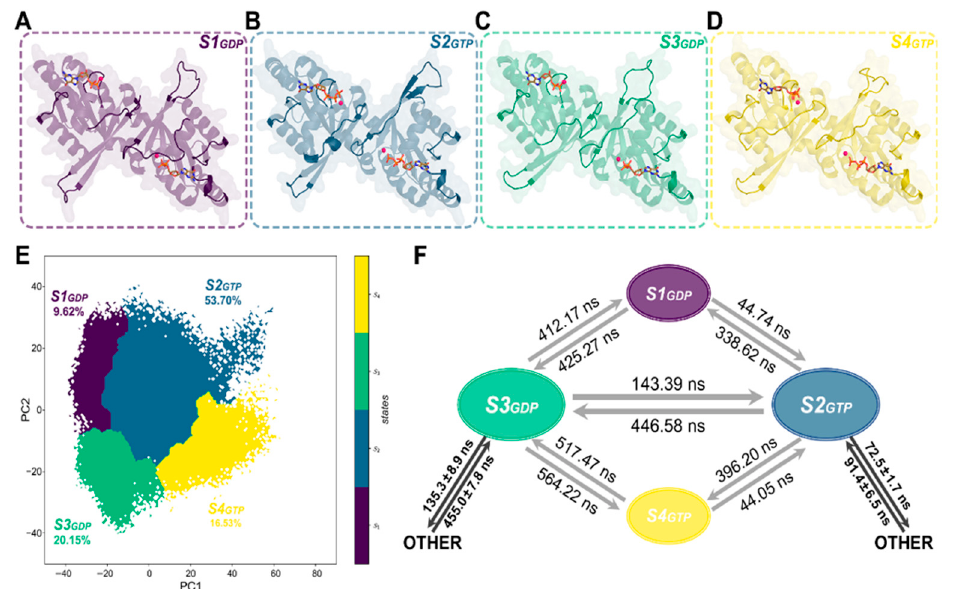
Figure 2. Representative structures of the four metastable states in ROCs-GDP~ROCs-GTP MSMs: ( A ) S1 GDP for macrostate S1 , ( B ) S2 GTP for macrostate S2 , ( C ) S3 GDP for macrostate S3 , and ( D ) S4 GTP for macrostate S4 . Structural segments that exhibited significant differences are highlighted in the opaque cartoon, with the remaining being transparent. ( E ) Distribution of the four metastable states in Rocs-GDP~ROCs-GTP MSMs with the portion of each macrostate. ( F ) Transition time between the macrostates calculated by mean first passage time (MFPT). OTHER: denoted the transition between S2 GTP / S3 GDP and all other remaining metastable states.